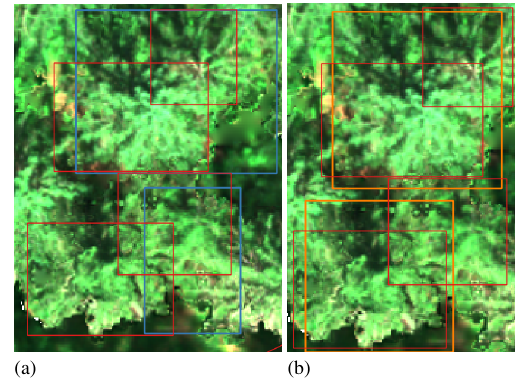
Figure 7. Sample area from coniferous plot #1 showing detection issues for small closeby trees. Reference bounding boxes are in red. a) Detected bounding boxes for DETR are in blue. b) Detected bounding boxes for YOLOv4 are in